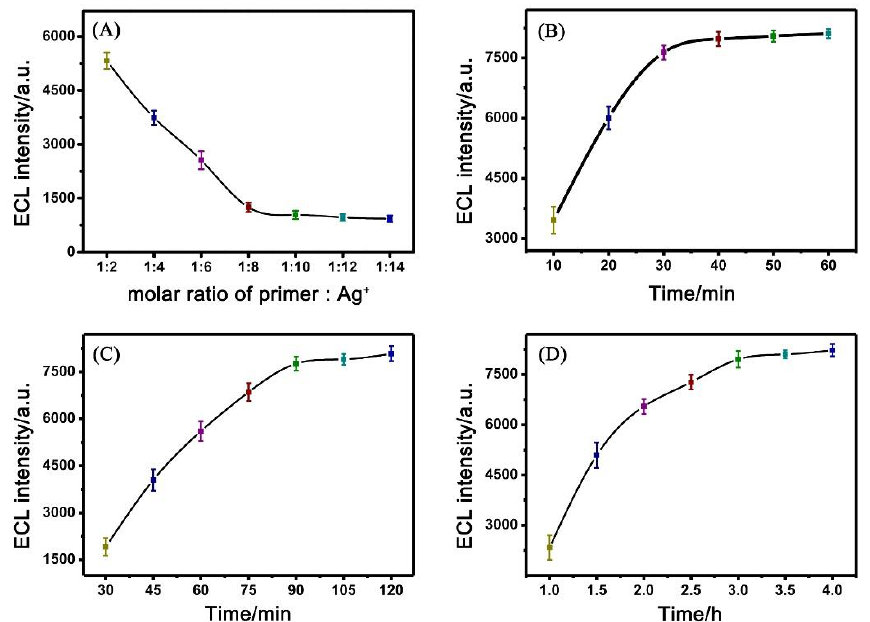
Figure 3. The effects of ( A ) the molar ratio of a primer and Ag + ; ( B ) H 2 S enrichment reaction time; ( C ) the time of HCR reaction; and ( D ) intercalation time between Ru(phen) 32+ and dsDNA. The error bars show the standard deviation of three replicate determinations.